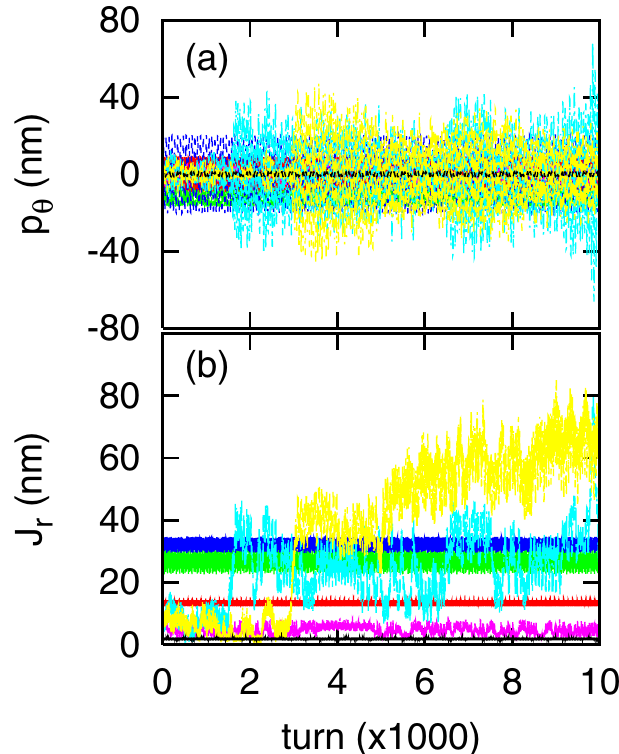
motion is regarded as an external (cid:11) motion is en- r